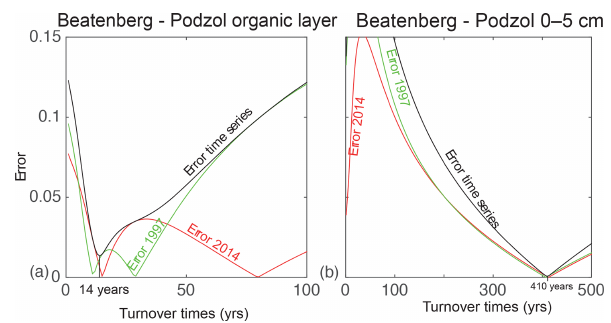
Figure 2. Numerical optimization of least mean-square error reduc- tion, showing the reduction of error spread for two soil depths. For the Beatenberg Podzol organic layer (a) the individual 14 C time points for both 1997 and 2014 both yield two solutions and are al- most equally likely (i.e., the error nears zero). The combined opti- mization using both time points reveals the likeliest option. For the (b) 0–5cm layer, the single time points only have a single likely solution.